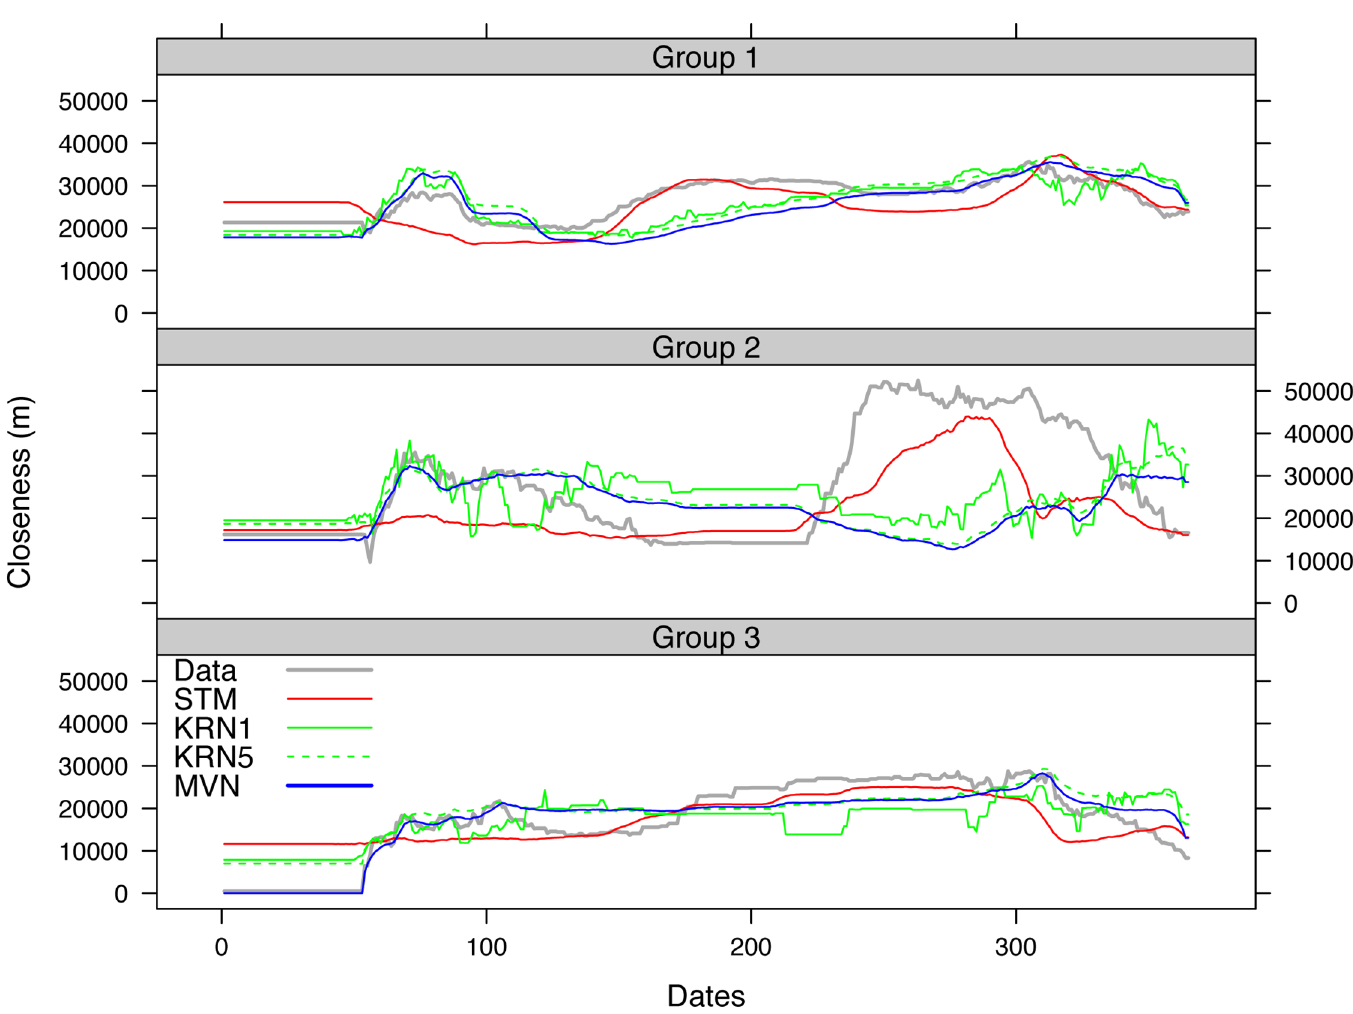
Fig 11. Daily mean closeness between pastoralists obtained from the 2007 – 2008 data and 100 simulations using STM, KRN, and